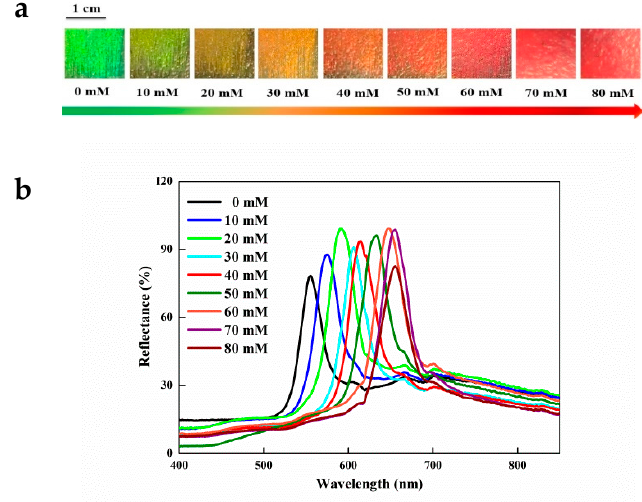
Figure 3. ( a ) Color change of the IOPPCs in different concentrations of PNP; ( b ) optical response of the IOPPCs in different concentrations of PNP.